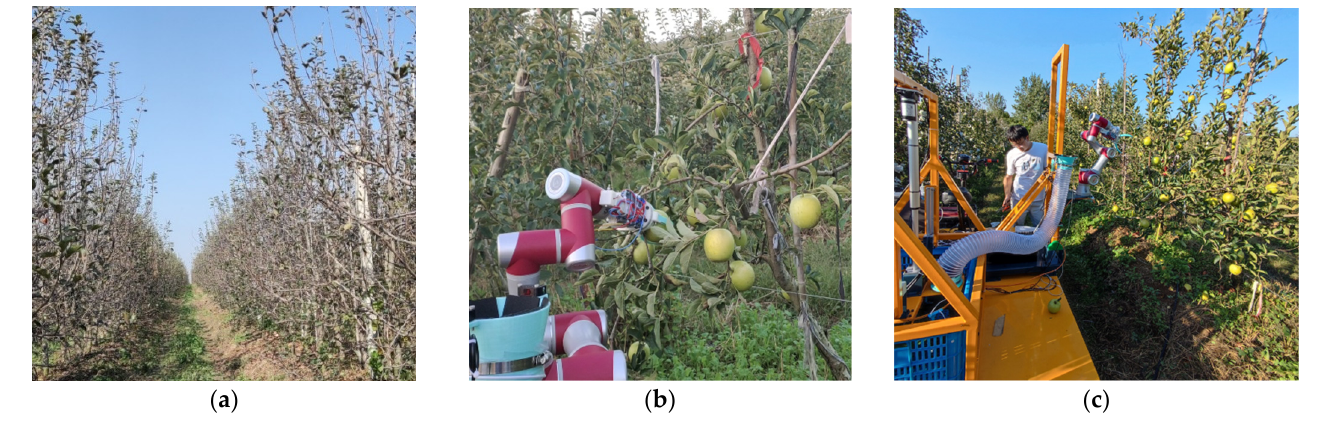
Figure 1. Pictures of the growth of apple trees in an orchard in Wendeng District, Weihai City, Shandong Province, China: ( a ) picture of orchard condition; ( b ) picture of fruit growing on tree; ( c ) picture of apple picking experiment.